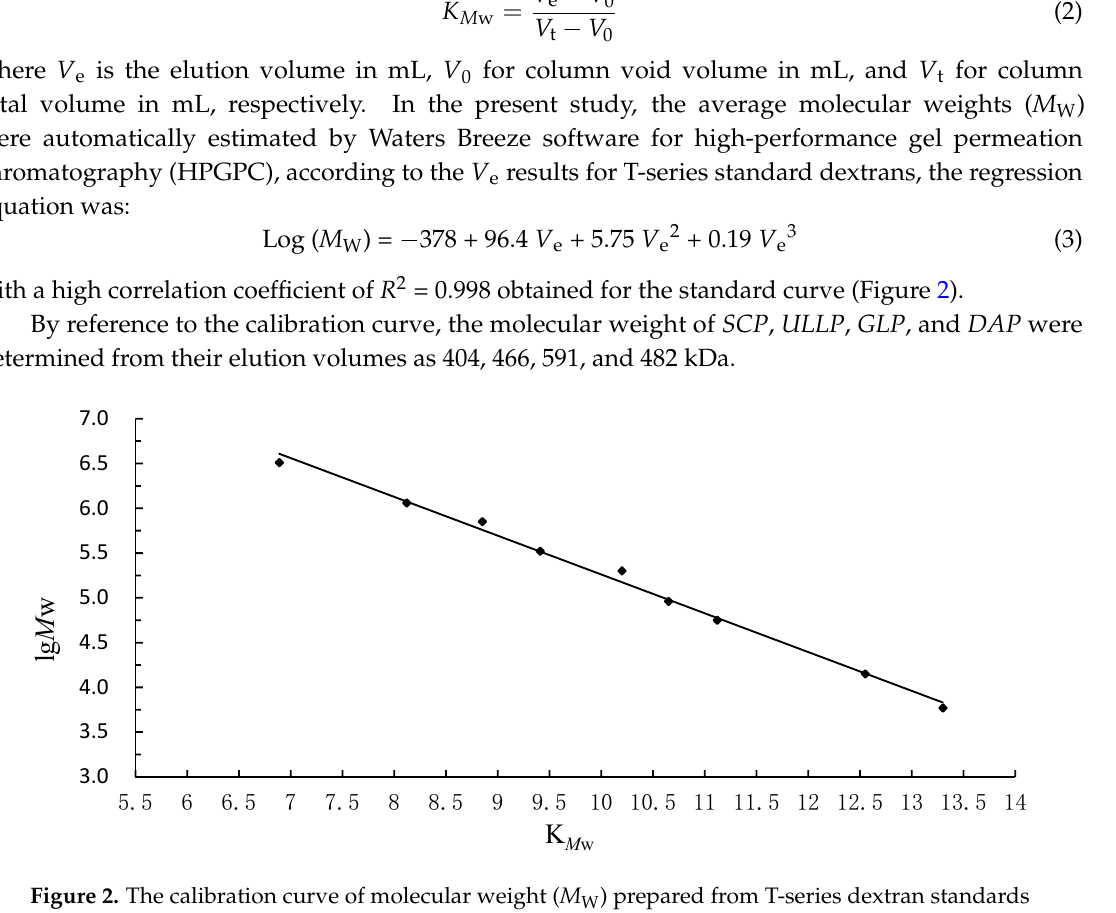
Figure 2. The calibration curve of molecular weight ( M W ) prepared from T-series dextran standards with HPGPC (high-performance gel permeation chromatography).